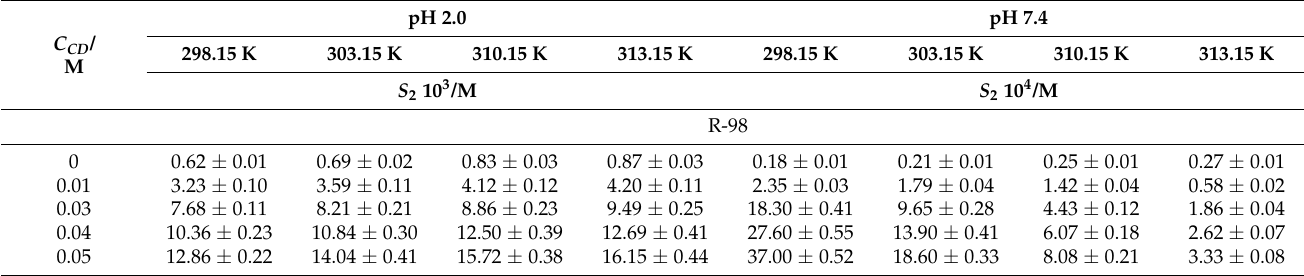
Table 1. Experimental solubility ( S 2 ) in buffer pH 2.0 and buffer pH 7.4 with different 2-HP- β -